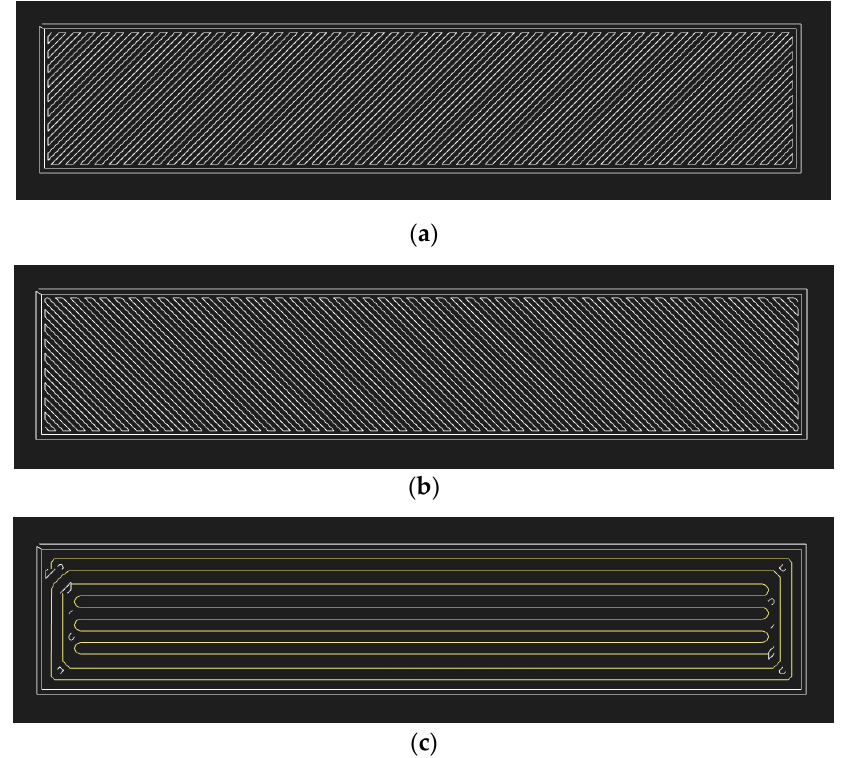
Figure 1. Printing orientation for Onyx and reinforcements. ( a ) Onyx layer with +45° printing ori- tation; ( b ) Onyx layer with − 45 ◦ printing orientation; ( c ) Fiber reinforcement layer with hybrid entation; ( b ) Onyx layer with −45° printing orientation; ( c ) Fiber reinforcement layer with hybrid infill